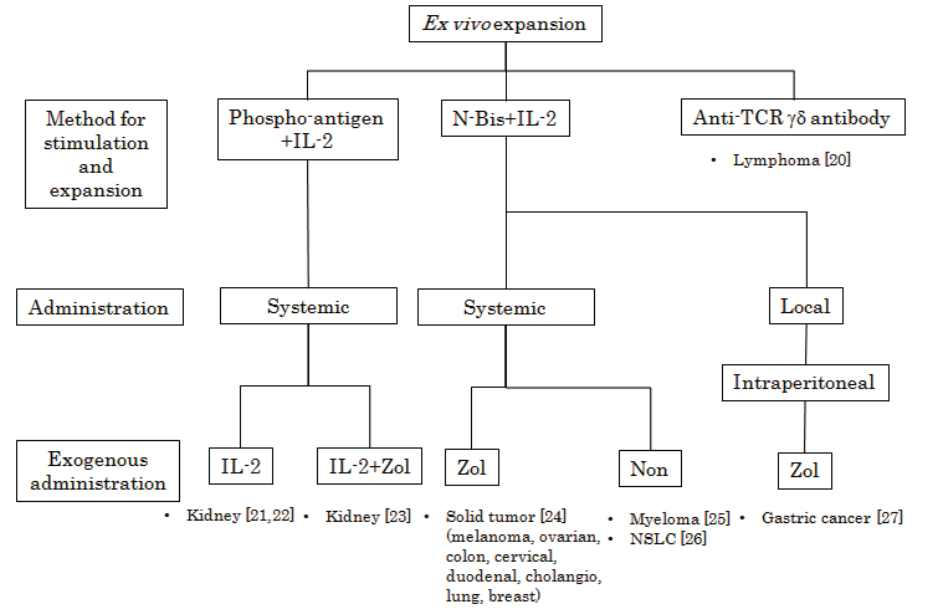
Figure 2. Peripheral blood mononuclear cells (PBMCs) were obtained from patients